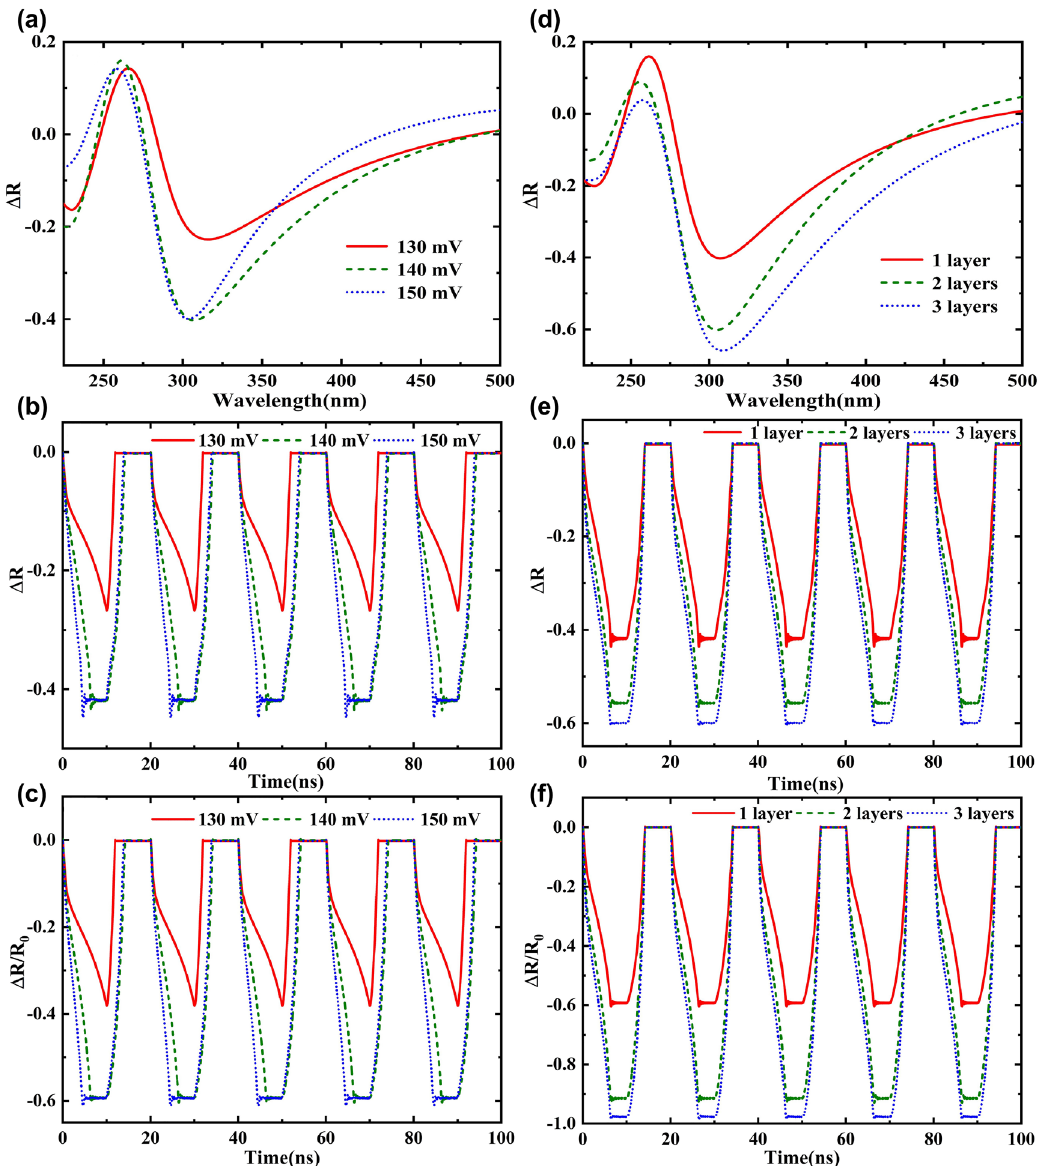
Figure 4: The reflection varies with voltage or the number of graphene layers. (a) Absolute variation of reflection with wavelength at different voltages. (b) The absolute change of reflection under different voltages varies with time. (c) The relative change of reflection with time under different voltages. (d) The absolute variation of reflection with wavelength at different graphene layers. (e) The absolute change in reflection of different graphene layers over time. (f) The relative change of the reflection of different graphene layers over